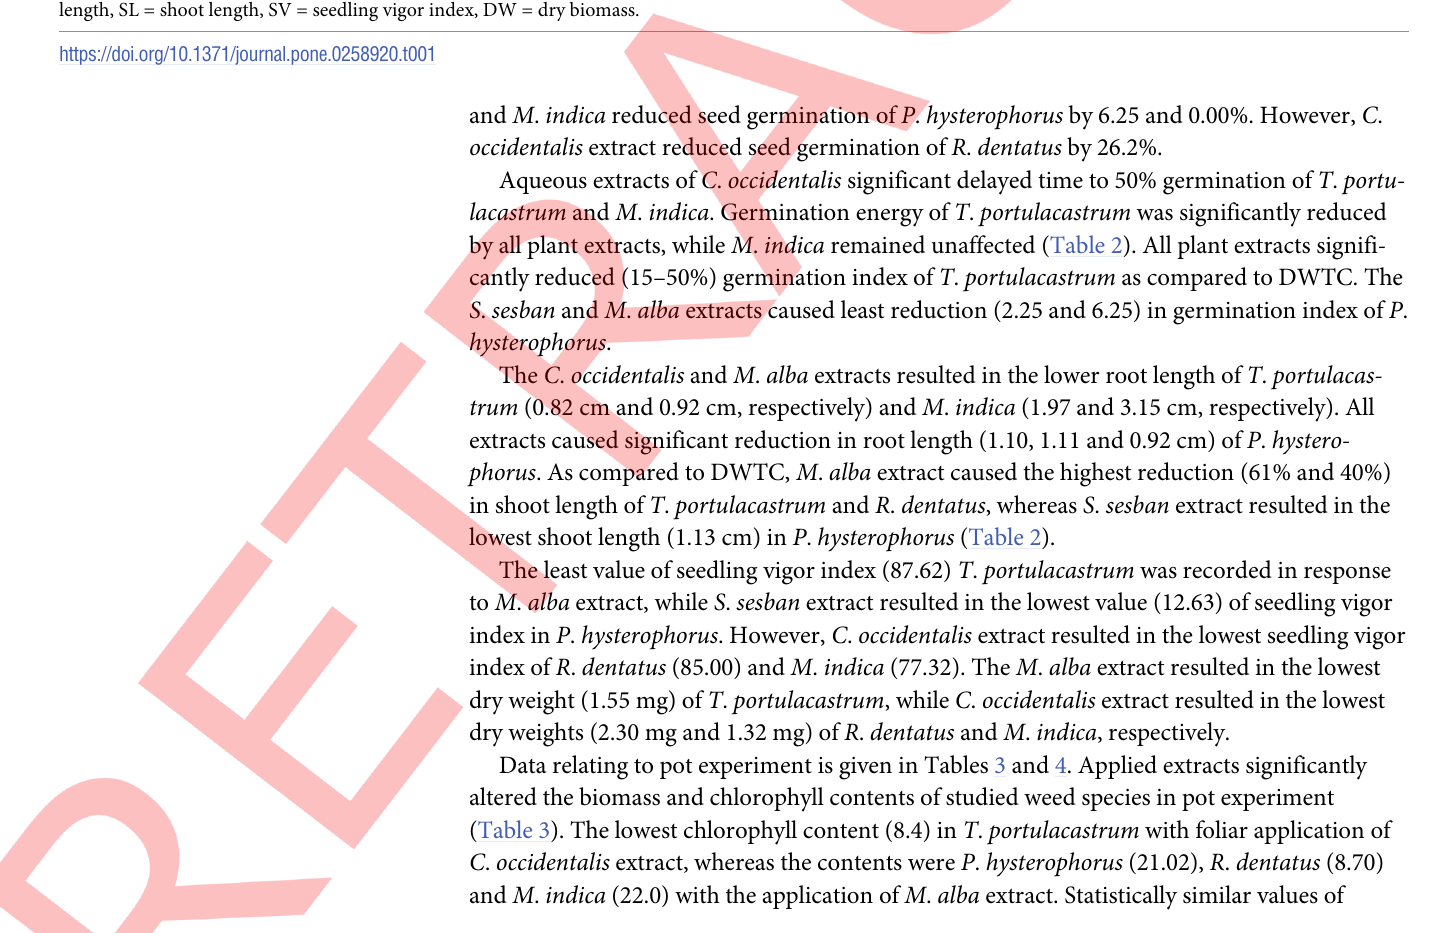
50 = time to 50% germination, GE = germination energy, GI = germination index, RL = root